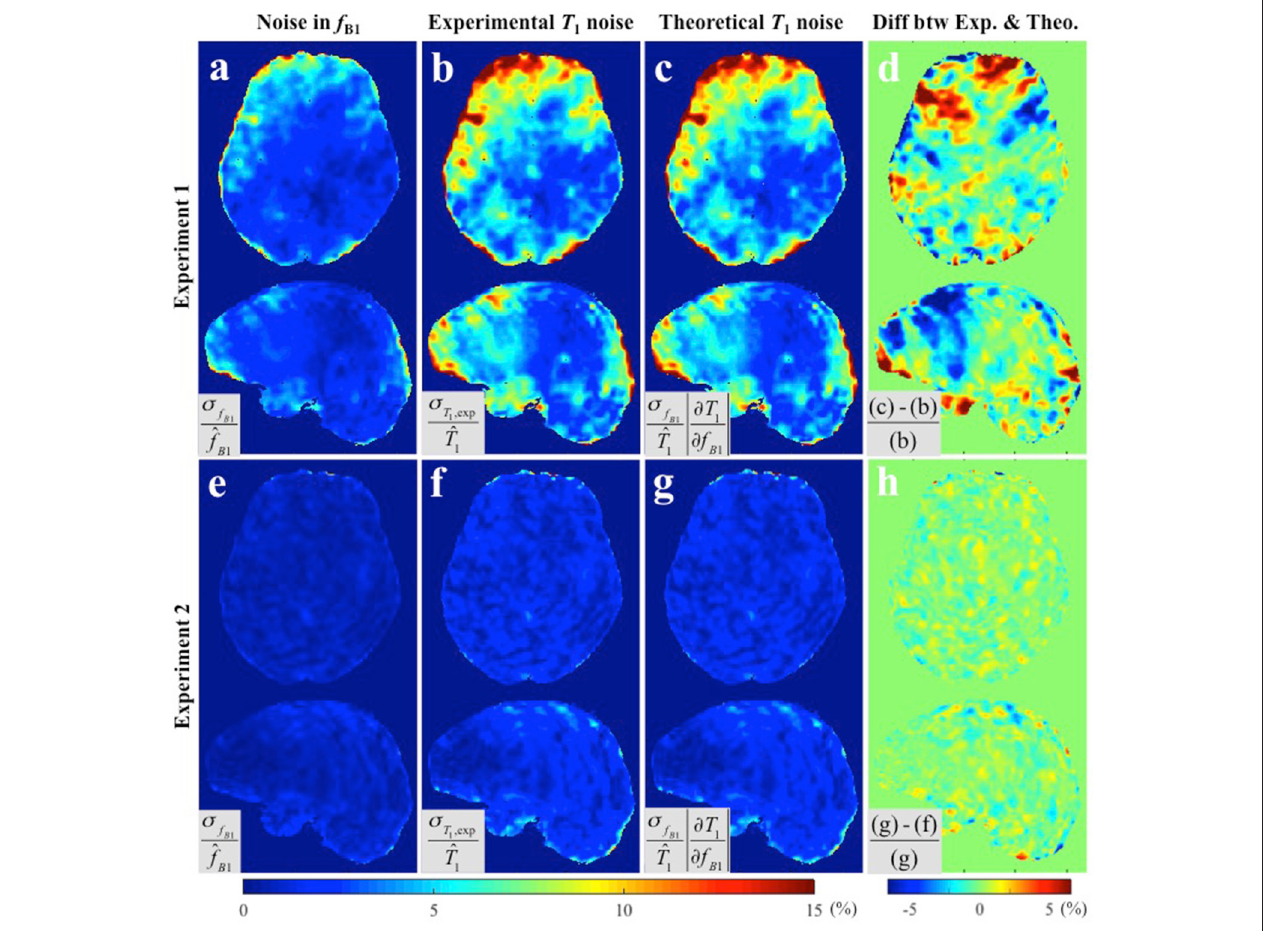
FIGURE 3 | CV maps of (a,e) the six f B 1 acquired with small and large spoiler gradients in Experiments 1 and 2 , (b,f) the noise of the measured T 1 maps ( Experimental variance evaluation ), and (c,g) the theoretically-predicted noise in the T 1 map from the second term in Equation (5), i.e., 100 · σ f ( Theoretical variance evaluation ). (d,h) The percentage difference maps between experimentally-measured and theoretically-predicted noise in T 1 estimates. All CV maps shown were calculated by the equations shown in the corresponding gray boxes multiplied by 100. Here, ˆ f B 1 and ˆ T 1 represent the means across six f B 1 and corresponding T 1 maps